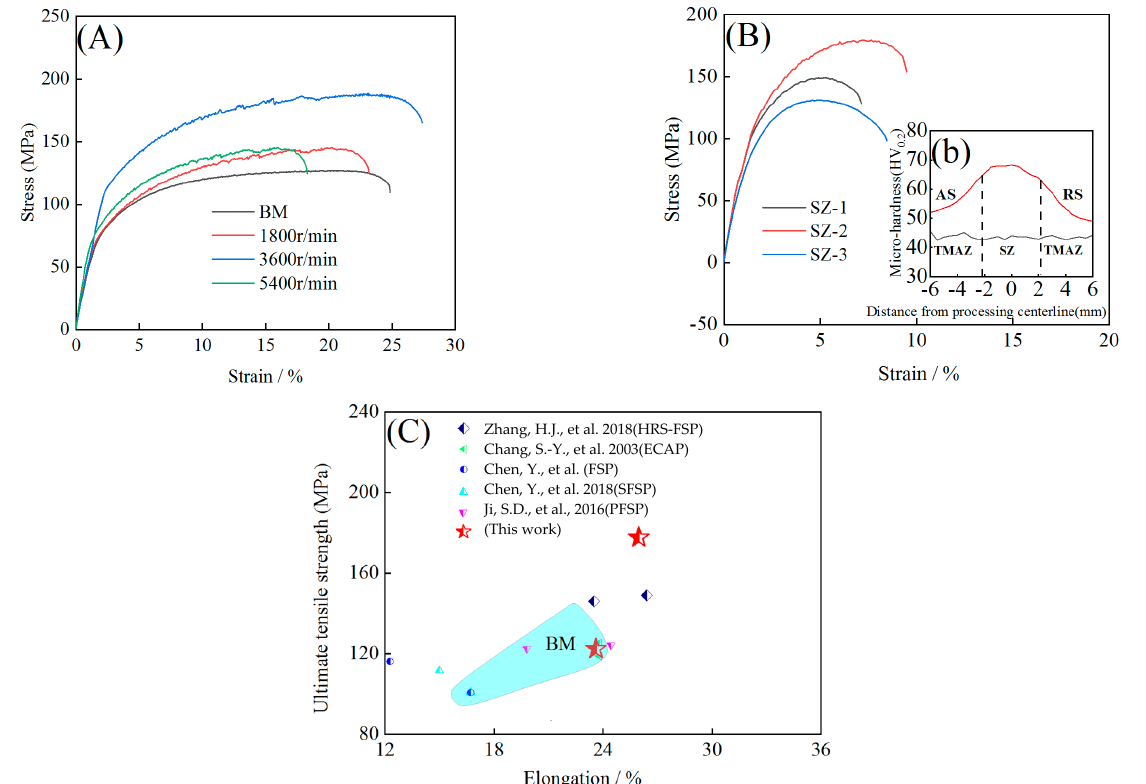
Figure 3. ( A ) Engineering strain curves of different processing parameters; ( B ) Engineering stress-strain curve of different zone in 3600 r/min; ( b ) micro-hardnessand ( C ) references comparison [13,28–30] .